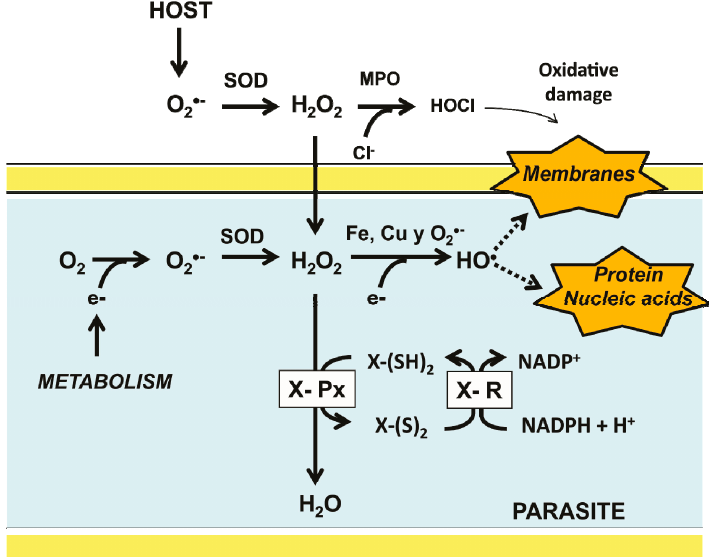
Figure 1 . Major pathways for ROS production in invertebrate parasites inside its host and the antioxidant defense system. Superoxide anion (O 2 − ) is produced as a metabolic byproduct in both the parasite and